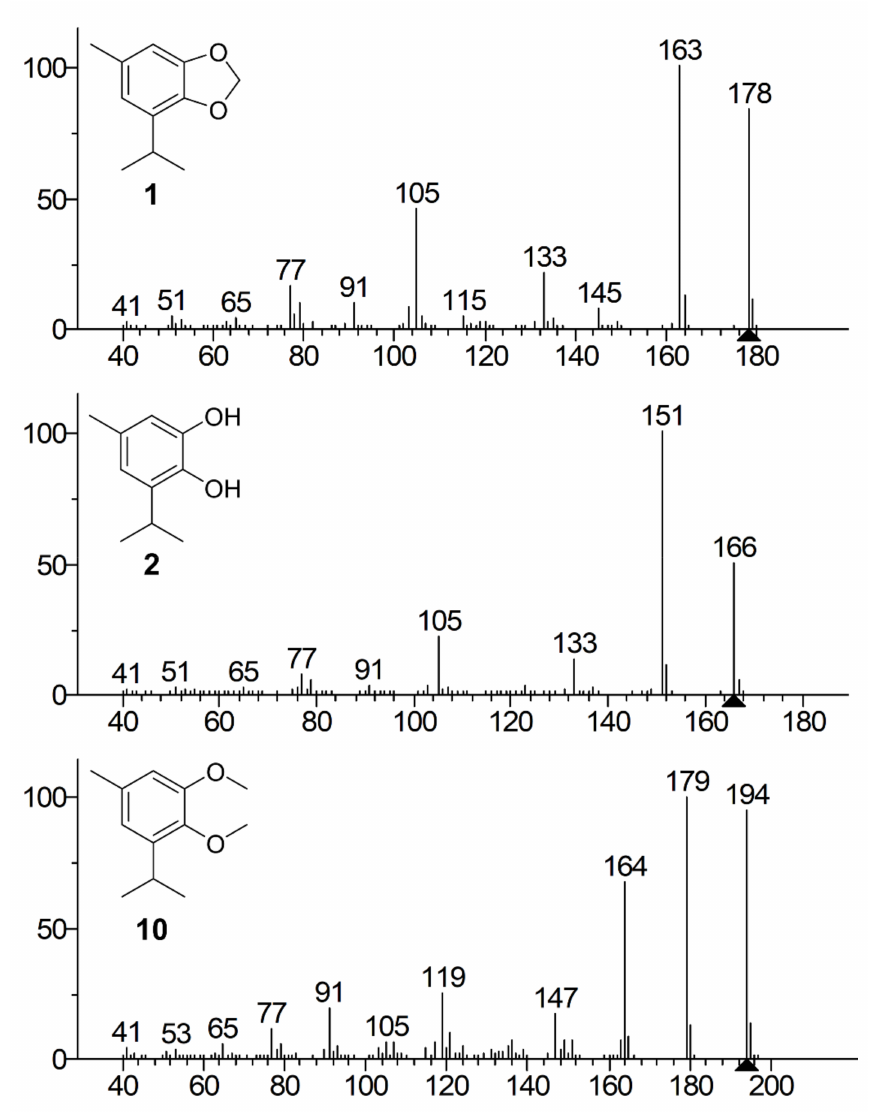
Figure 2. Mass spectra of compounds 1 , 2 and 10